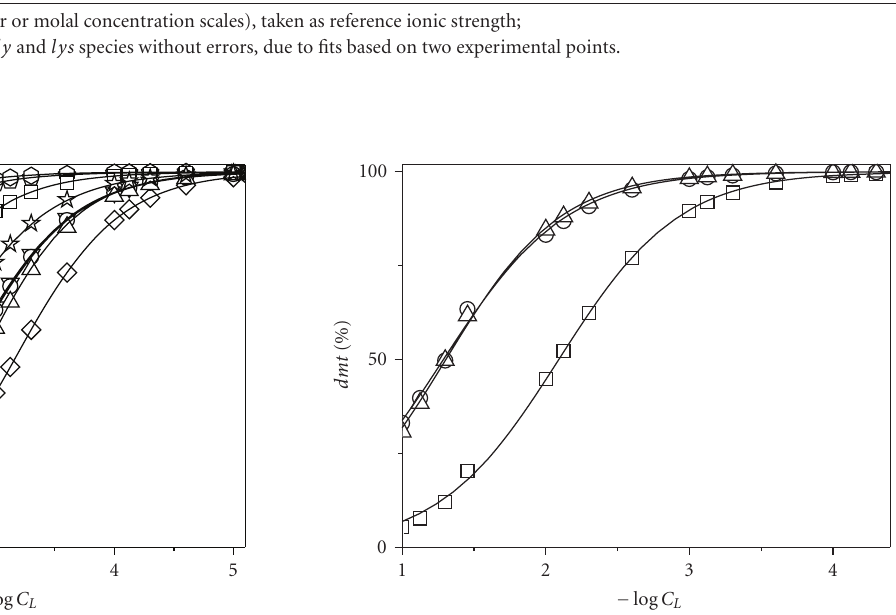
Figure 4: Dimethyltin(IV) sequestration diagrams in presence of various ligands. Percentage of noncomplexed dmt as a function of total ligand concentration (as − log C L ) at I = 0 . 1 mol L − 1 in NaCl aq and pH = 6.50. Total concentration of dmt , C dmt =